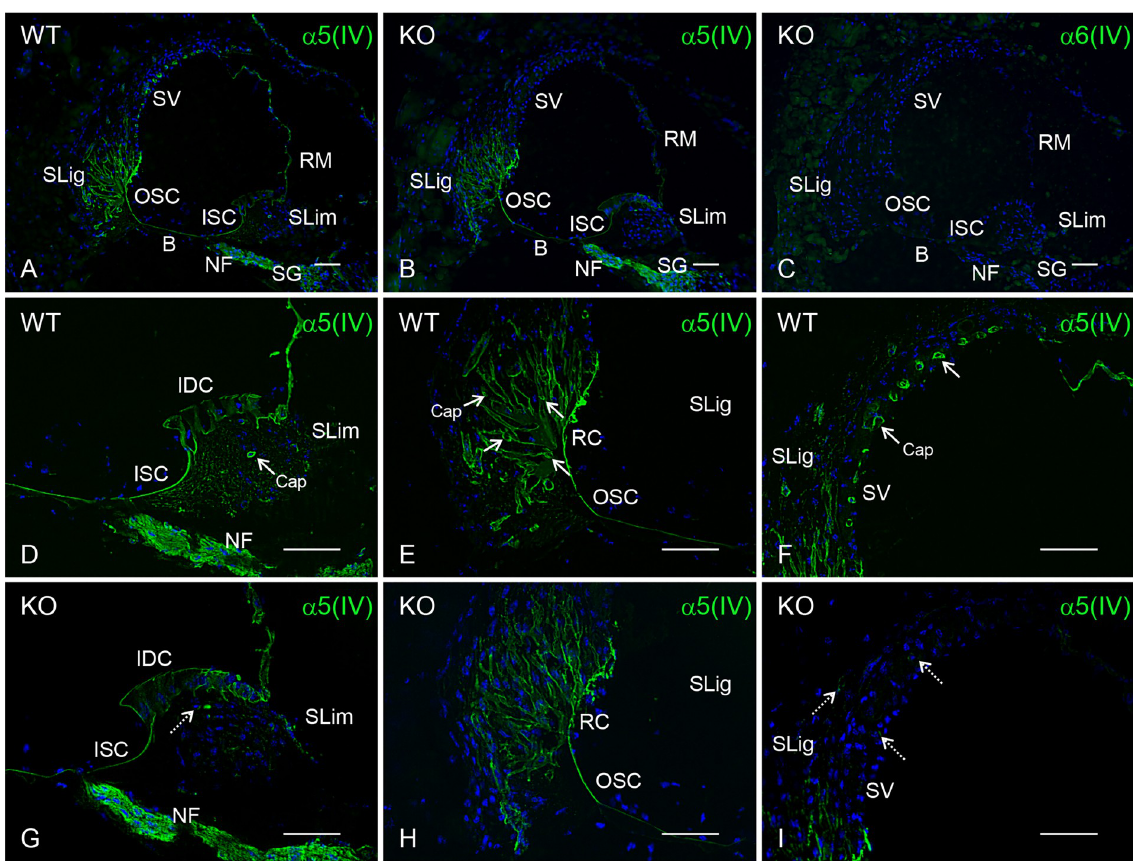
Fig 3. Distribution of collagen α 5(IV) chain in the cochlea of WT and Col4a6 KO mice. (A, D–F) The collagen α 5(IV) chain located in the subepithelial BMs, perivascular BMs, and perineural BMs in WT mice (green). (B, G–I) In Col4a6 KO mice, the α 5(IV) chain is widely distributed (green). However, weak signals were detected in the perivascular BMs of the spiral limbus (SLim), spiral ligament (SLig), and stria vascularis (SV) (dashed arrows). (C) No immunopositive signal of the collagen α 6(IV) chain was present in Col4a6 KO mouse cochlea (green). Nuclei were counterstained with Hoechst 33258 (blue). B, basilar membrane; RM, Reissner’s membrane; NF, neural fasciculus; SG, spiral ganglion; IDC, interdental cells; ISC, inner sulcus cells; OSC, outer sulcus cells; RC, root cells; Cap, capillary. Scale bars = 50 μ